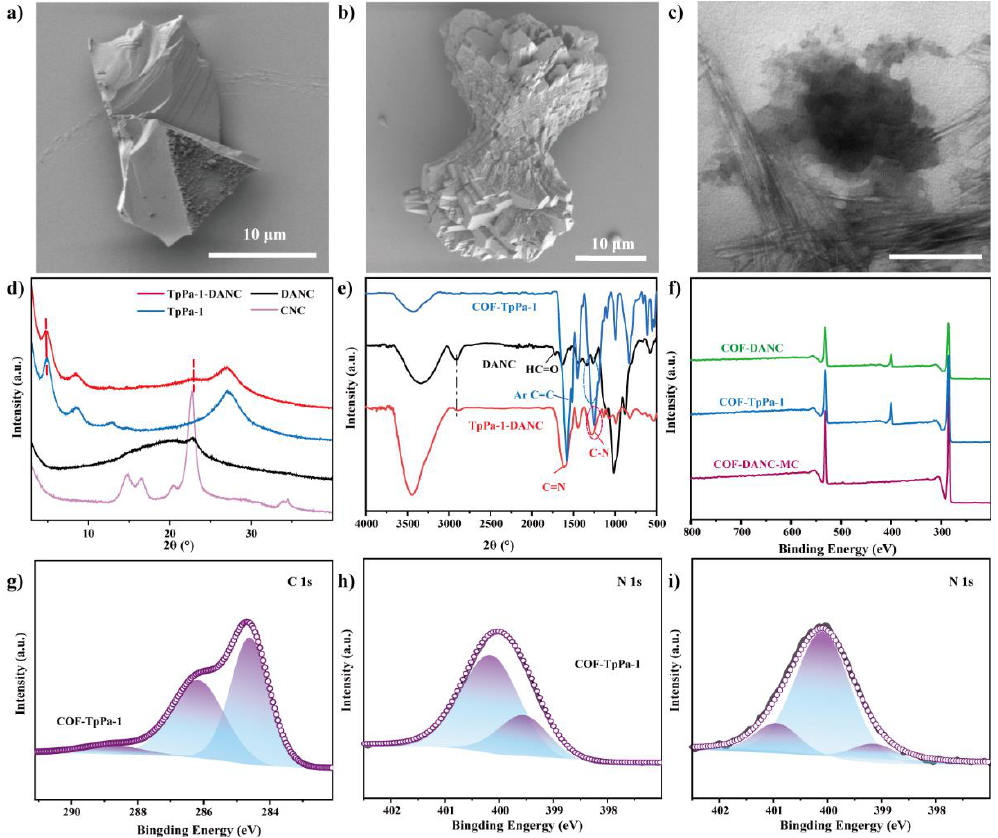
Figure 3. SEM (10 μm) ( a , b ) and TEM images (200 nm) ( c ) of TpPa-1-DANC; ( d ) XRD and ( e ) FTIR of TpPa-1, DANC, CNC and TpPa-1-DANC; ( f ) XPS full spectrum of TpPa-1 and TpPa-1-DANC; ( g ) C 1s image of COF-TpPa-1; ( h ) N 1s maps of TpPa-1 and ( i ) COF-DANC.